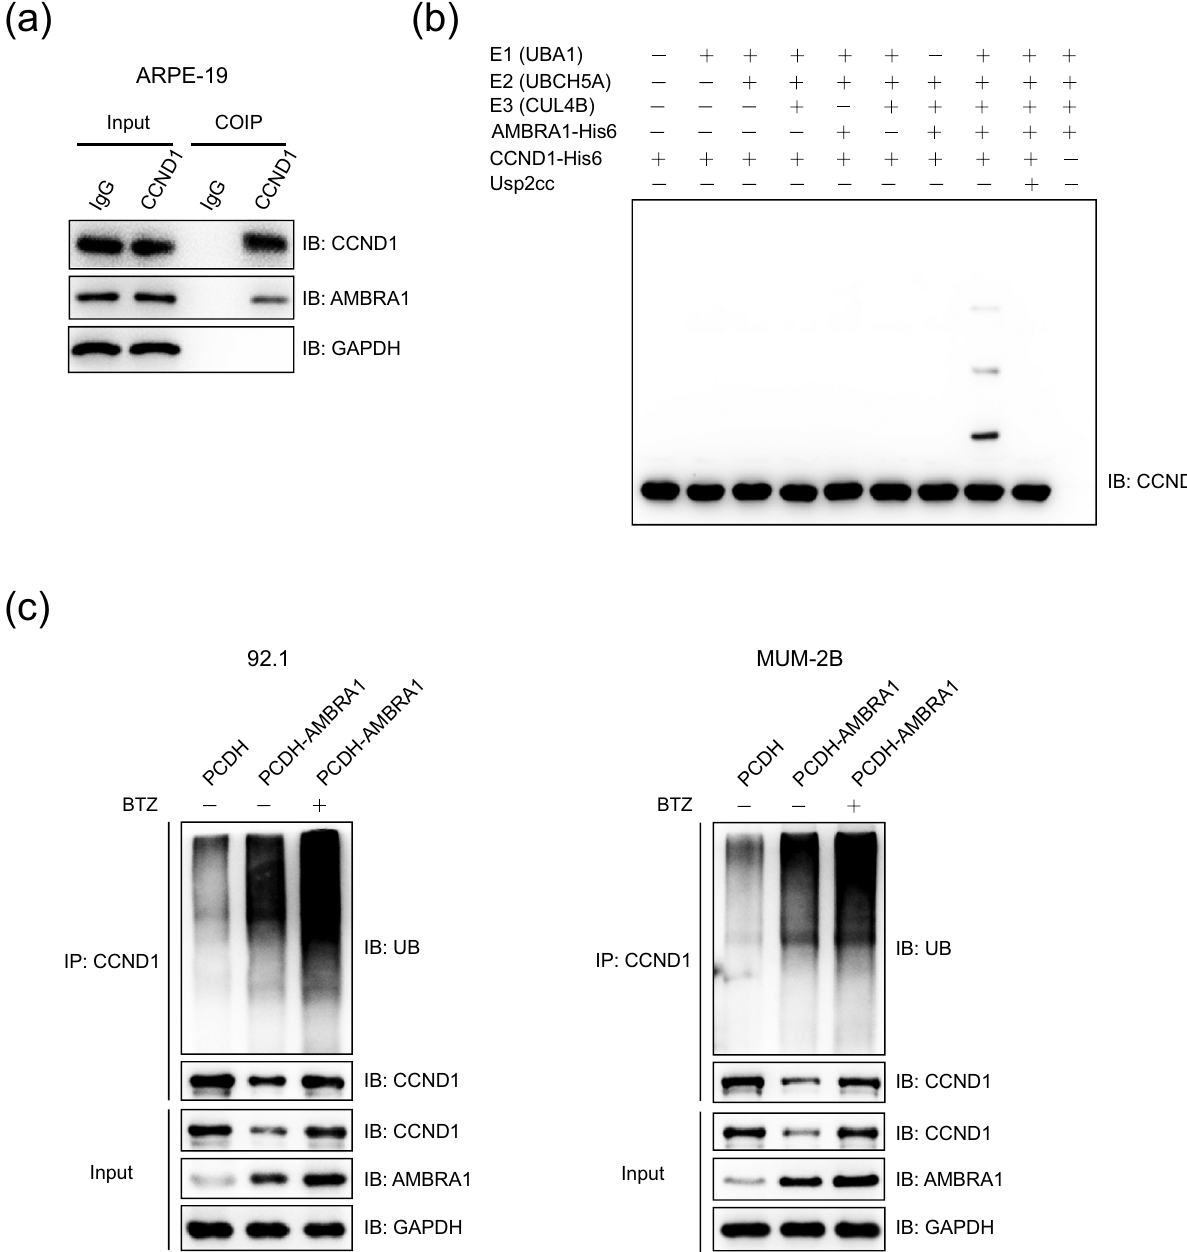
Figure 5: AMBRA1 interacts with and promotes the ubiquitination of CCND1. ( a ) Endogenous AMBRA1 interacted with CCND1. The lysates of ARPE - 19 cells were immunoprecipitated with anti - IgG or anti - CCND1 antibody and detected by immunoblotting analysis. ( b ) AMBRA1 mediated the ubiquitination of CCND1 in vitro . An in vitro ubiquitination assay was carried out with the recombinant proteins E1 ( UBA1 - His6 ) , E2 ( UBCH5A - His6 ) , E2 ( CUL4B - His6 ) , AMBRA1 - His6, CCND1 - His6, and His6 - Ub, together with the indicated components, and subjected to immunoblotting analysis. Usp2cc, the catalytic core of human deubiquitinase Usp2. ( c ) AMBRA1 promoted the ubiquitination of endogenous CCND1. MUM - 2B and 92.1 cells stably expressing empty vector PCDH or PCDH - AMBRA1 were treated with or without proteasome inhibitor BTZ ( 1 μ M ) for 6 h, and the lysates were immunoprecipitated with anti - CCND1 antibody before subjecting to immunoblotting analysis using indicated